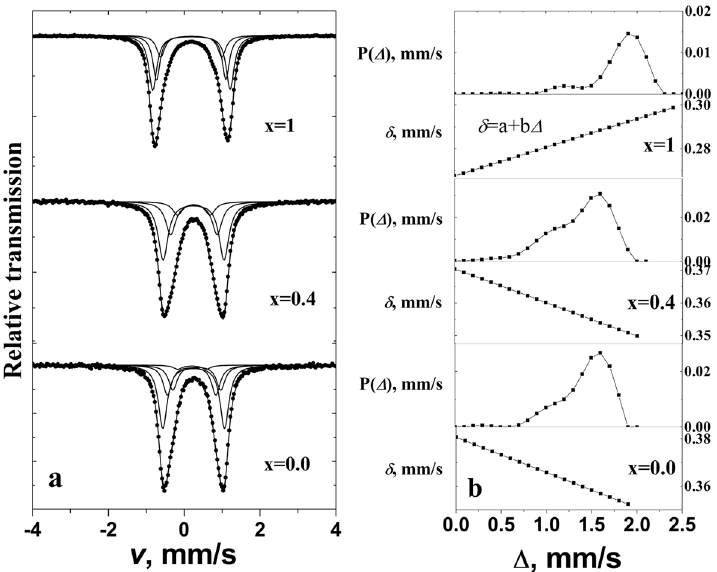
Figure 7. Mössbauer spectra of Y x Gd 1−x Mn 0.97 Fe 0.03 O 3 at room temperature fitted to doublets ( a ) and quadrupole splitting distribution P( ∆ ) with dependence of isomer shift δ on quadrupole splitting ∆ ( b ). Fitting of the spectra was performed using WinNormos-for-Igor software package (version 3.0, http://www.wisse l-gmbh.de).